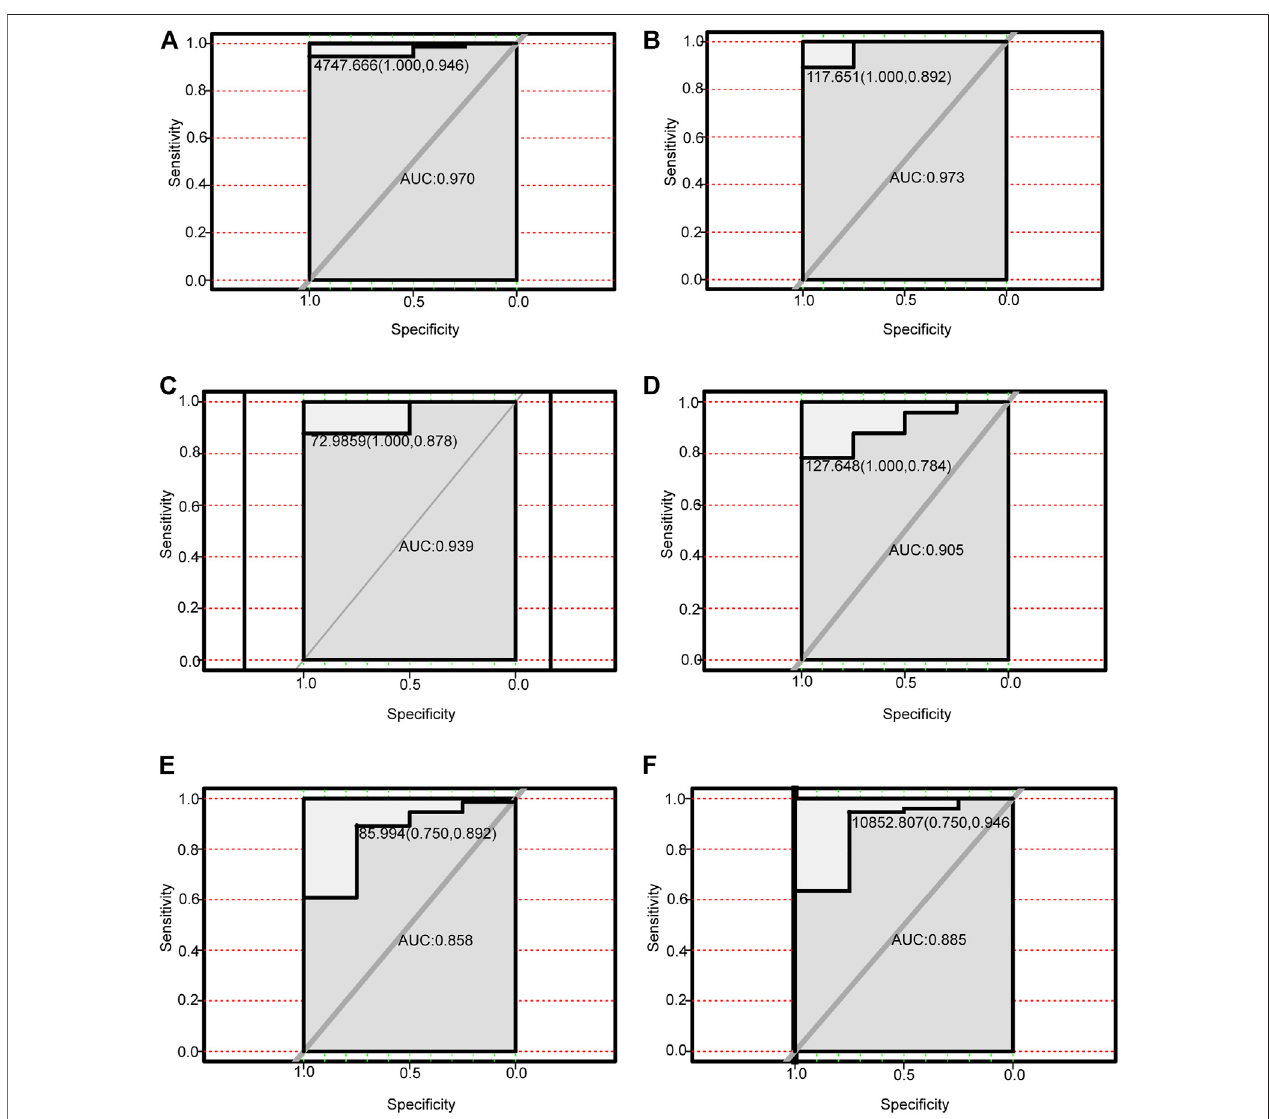
FIGURE 8 | Performance of autophagy-related DEmRNAs for diagnosing NAFLD (GSE130970). (A) ROC analysis of CTSD. (B) ROC analysis of FADD. (C) ROC analysis of BAK1. (D) ROC analysis of BAX. (E) ROC analysis of MAPK8IP1. (F) ROC analysis of HSPA8.